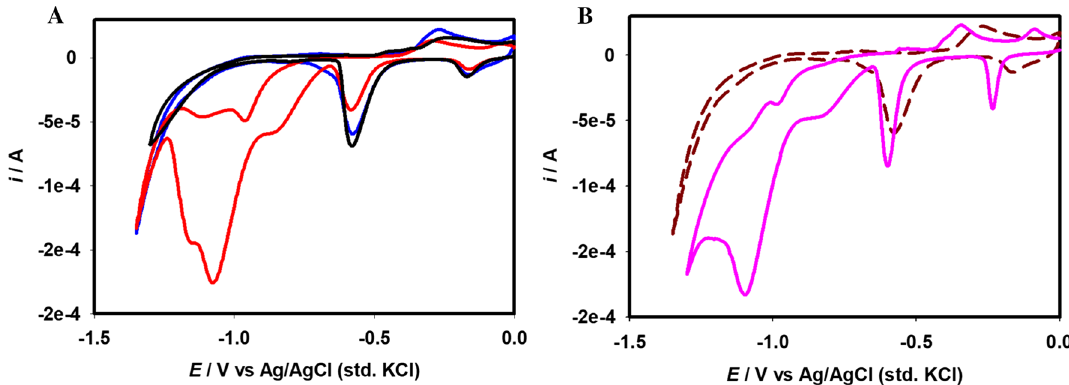
Fig. 4 Cyclic voltammograms of river waters recorded at a scan rate of 50 mV/s using a Pt–Cu working electrode in 0.1 M KCl. A Black line: Surma river water, Blue line: Dawki river water, Red line: Bur-